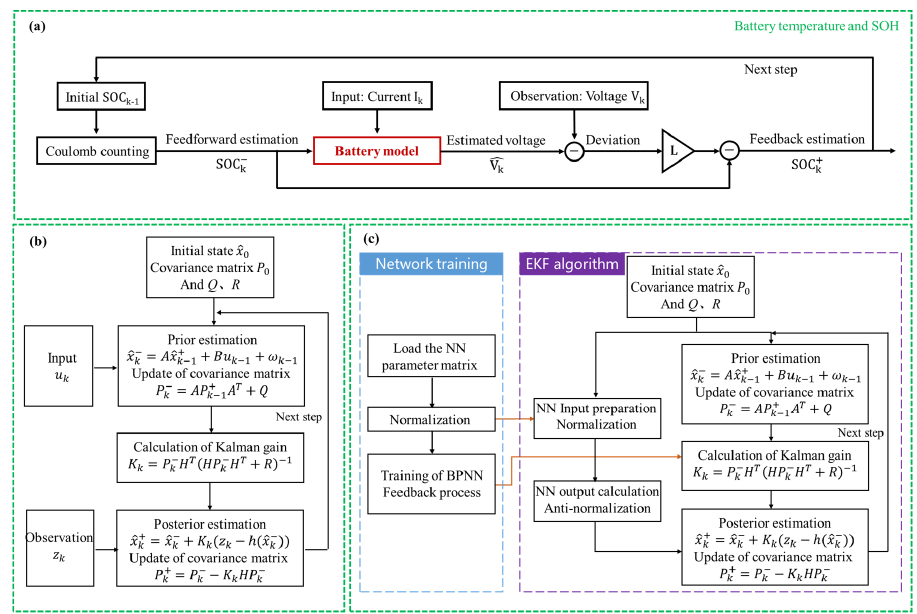
Figure 8. The EKF algorithm in estimating battery SOC. ( a ) The algorithm logic diagram. ( b ) The specific calculation process based on ECM. ( c ) The specific calculation process based on NN model.